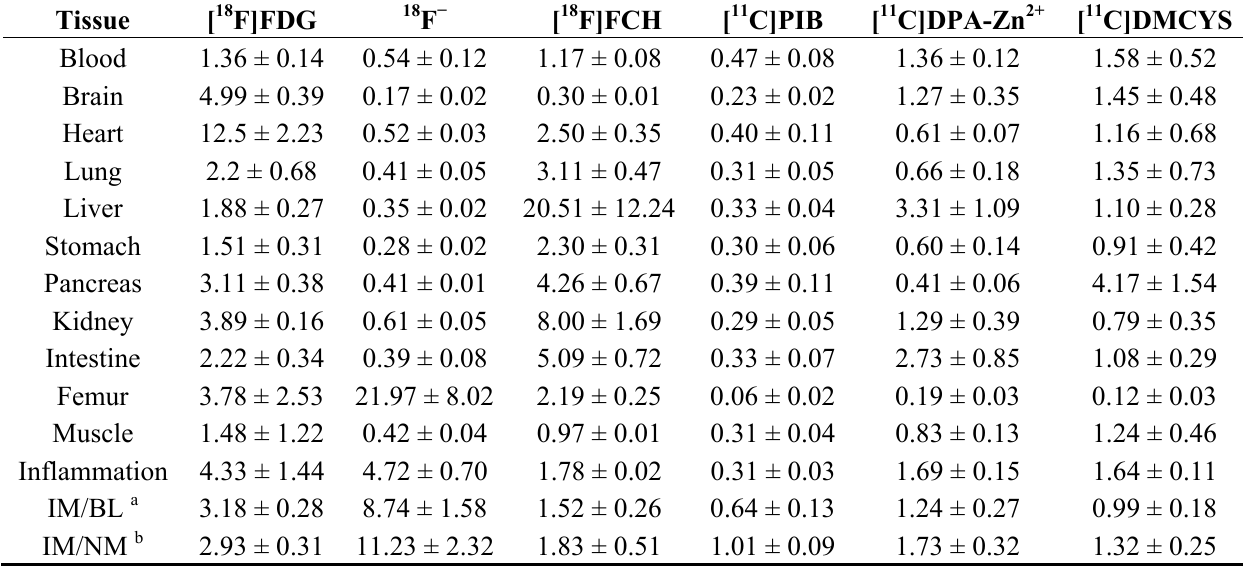
Table 1. Uptake of [ 18 F]FDG, 18 F − , [ 18 F]FCH, [ 11 C]PIB, [ 11 C]DPA-Zn 2+ , and [ 11 C]DMCYS in inflammatory mice at 60 min after injection (%ID/g, n = 3 per group, Mean ±